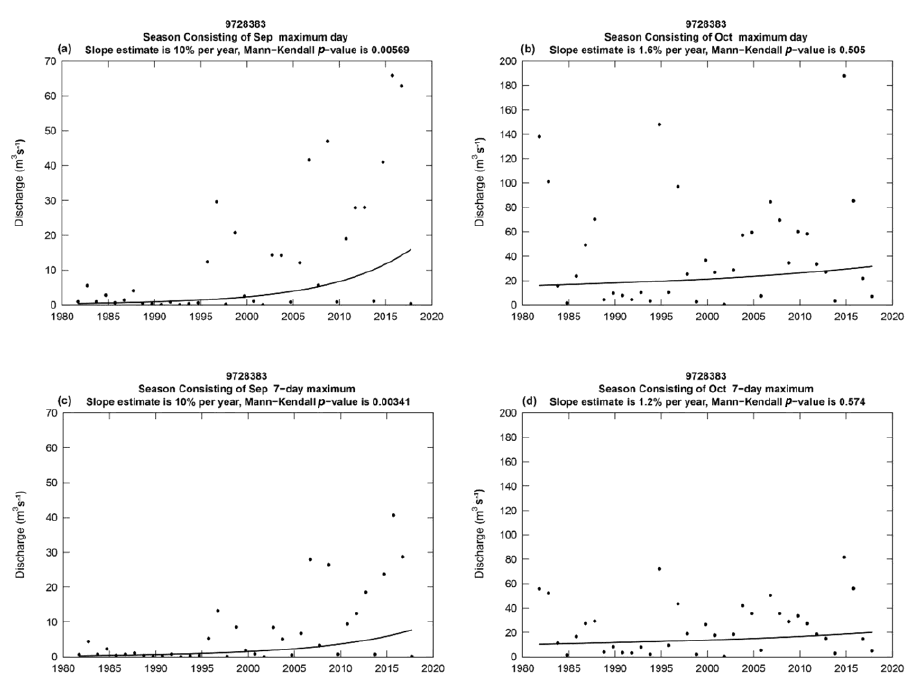
Figure 6. Trends of maximum 1-day and 7-day average discharges in the TITAR sub-basin during the period 1981 – 2017 for ( a , c ) September as well as ( b , d ) October, respectively. A Thiel-Sen slope and a two-sided p -value for the Mann-Kendall trend test are also presented in the graphs.